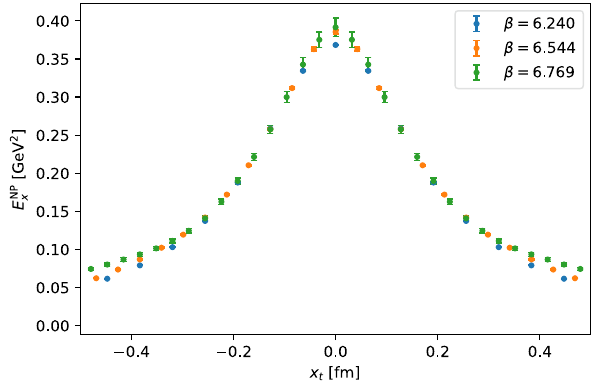
Fig. 4 Continuum scaling of the longitudinal component of the non- perturbative field E NP x at a transverse plane x l = d / 4 ≈ 0 . 128 fm